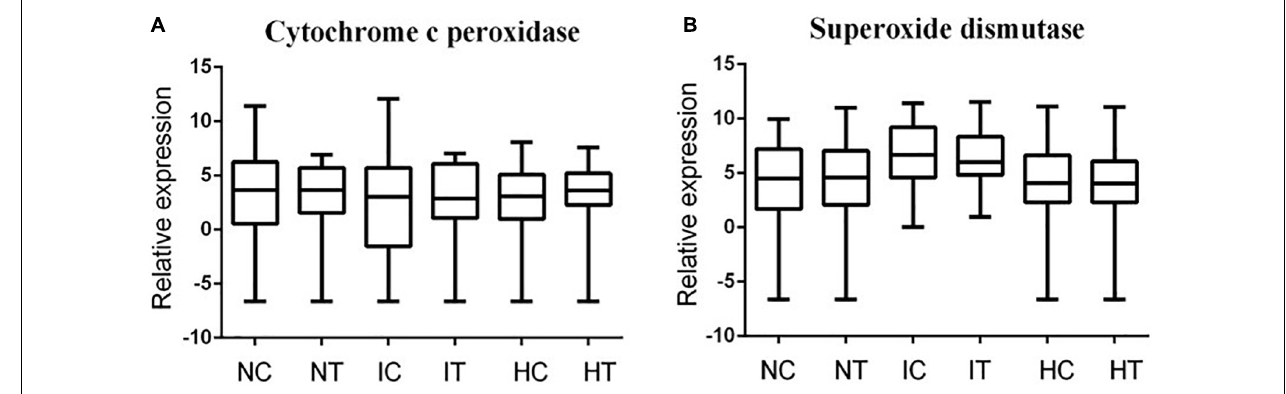
FIGURE 4 | Under Cd stress, expression of regulatory genes related to the enzymatic antioxidant pathway in leaves of two species, (A) expression of peroxidase gene, (B) expression of superoxide dismutase gene.